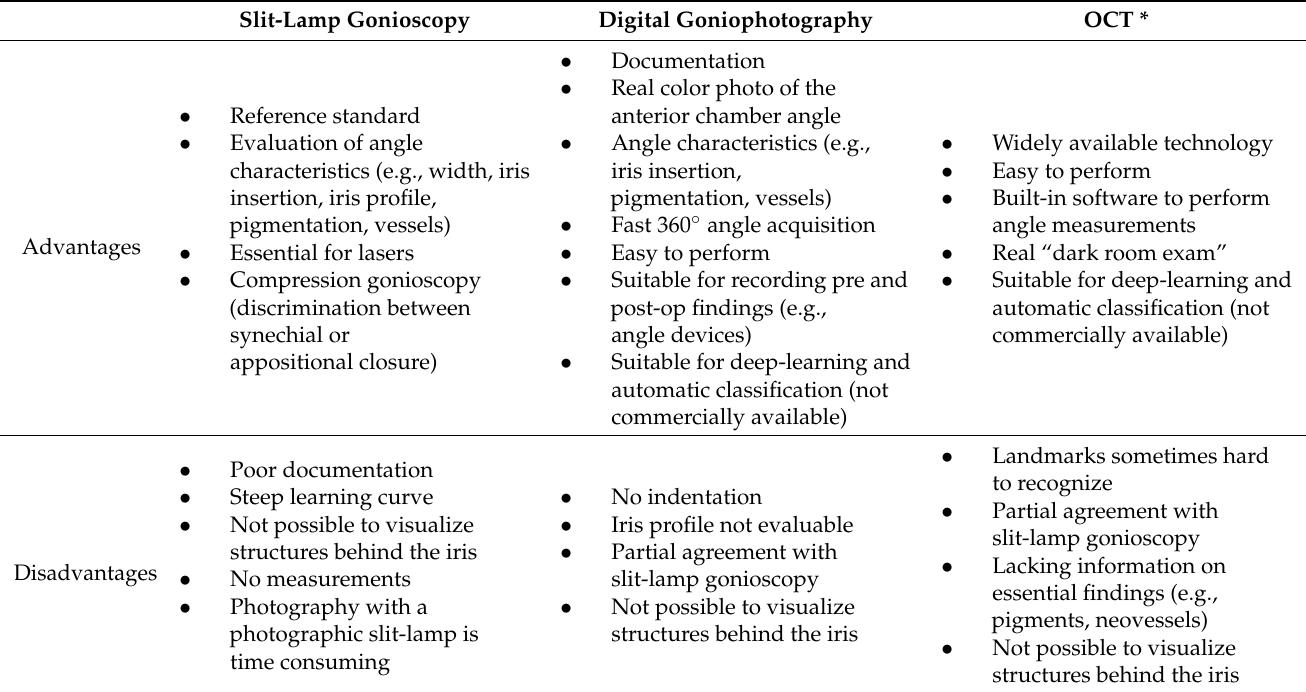
Table 1. Advantages and disadvantages of three different methods to inspect the anterior chamber